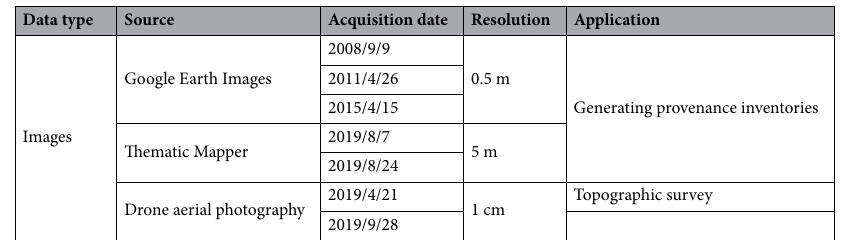
Table 2. Data used in this study.